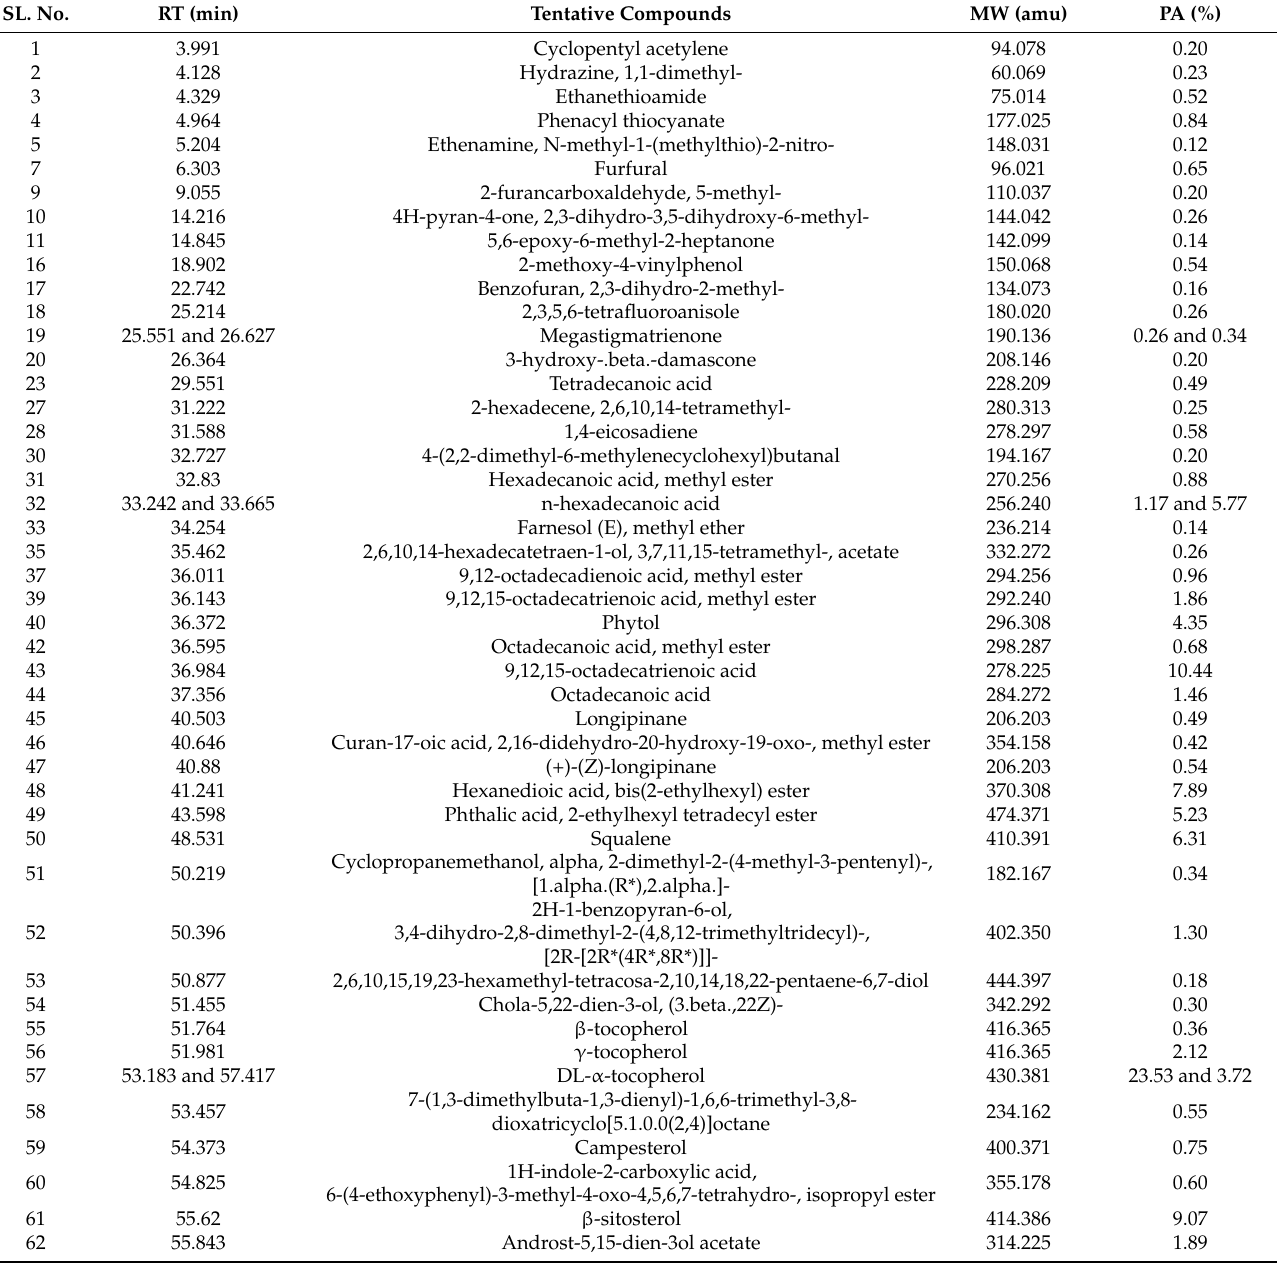
Table 1. List of tentative compounds identified in a methanol extract of Cnesmone javanica leaves (CV) by GC–MS analysis. SL.